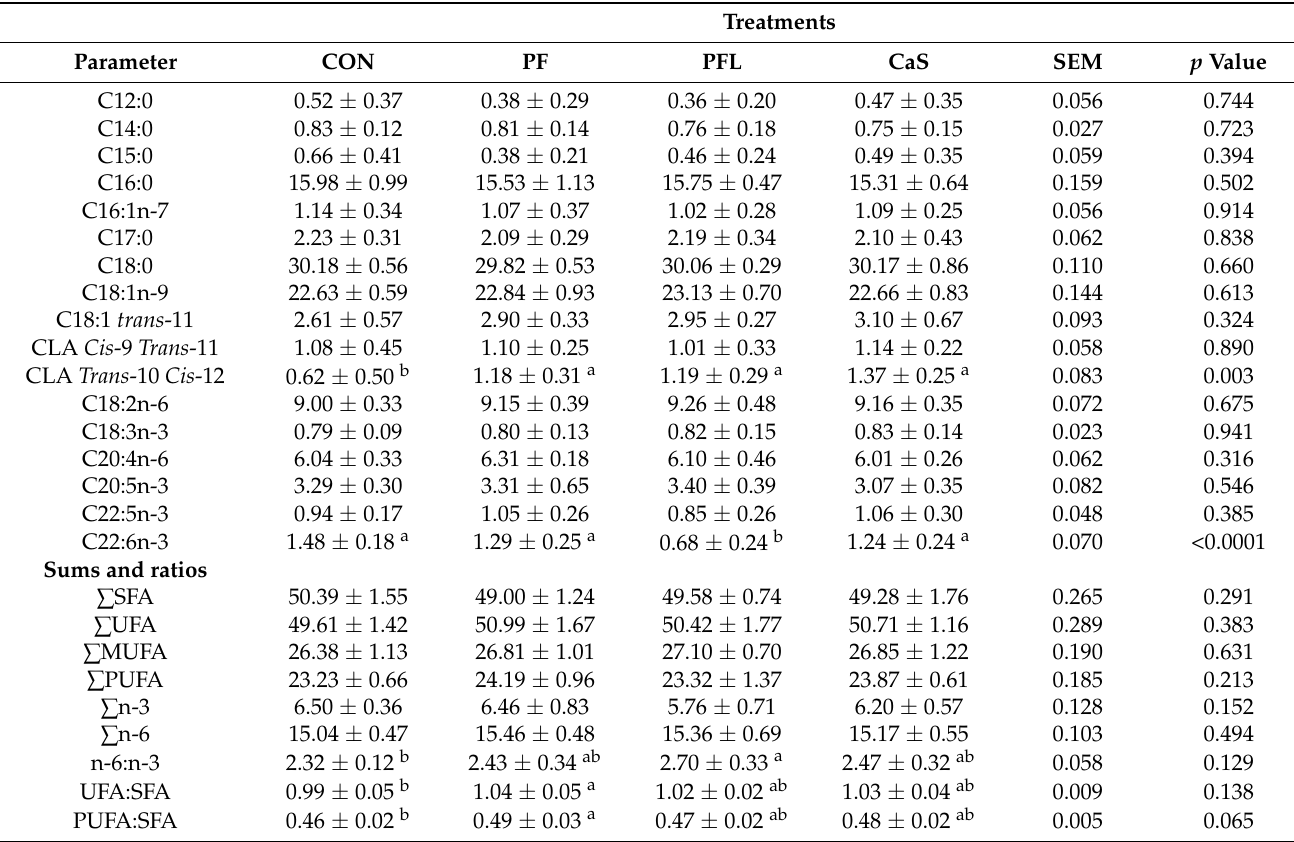
Table 6. The fatty acid composition of the liver in Dorper sheep.